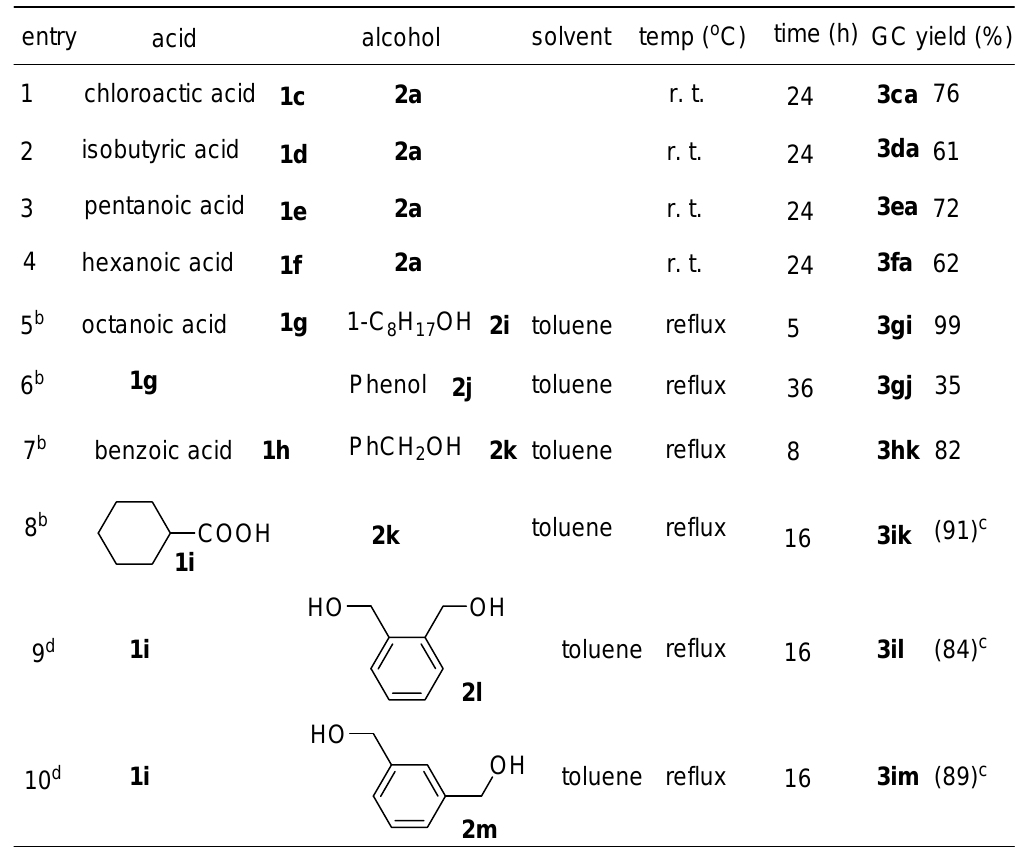
·8H O-catalyzed esterification of carboxylic acids with alcohols Table 4. ZrOCl 2 2